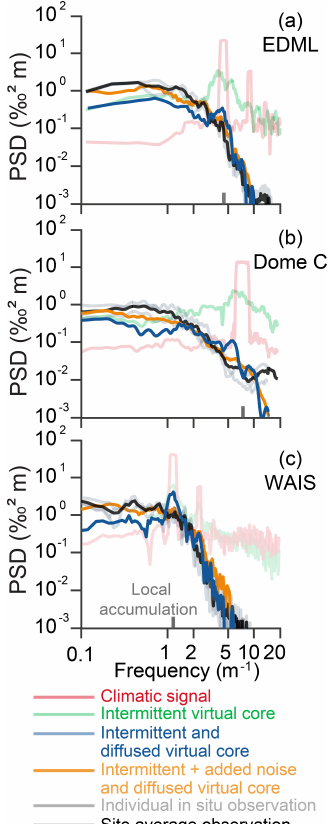
Figure 7. Power spectral density of the virtual ice cores com- pared to those of isotopes profiles from snow pits from (a) EDML, (b) Dome C, and (c) WAIS: climatic signal (light red), intermit- tent virtual core (light green), intermittent and diffused virtual core (light blue), intermittent plus added noise and diffused virtual core (orange), and snow pits from the sites (individual: grey; average: